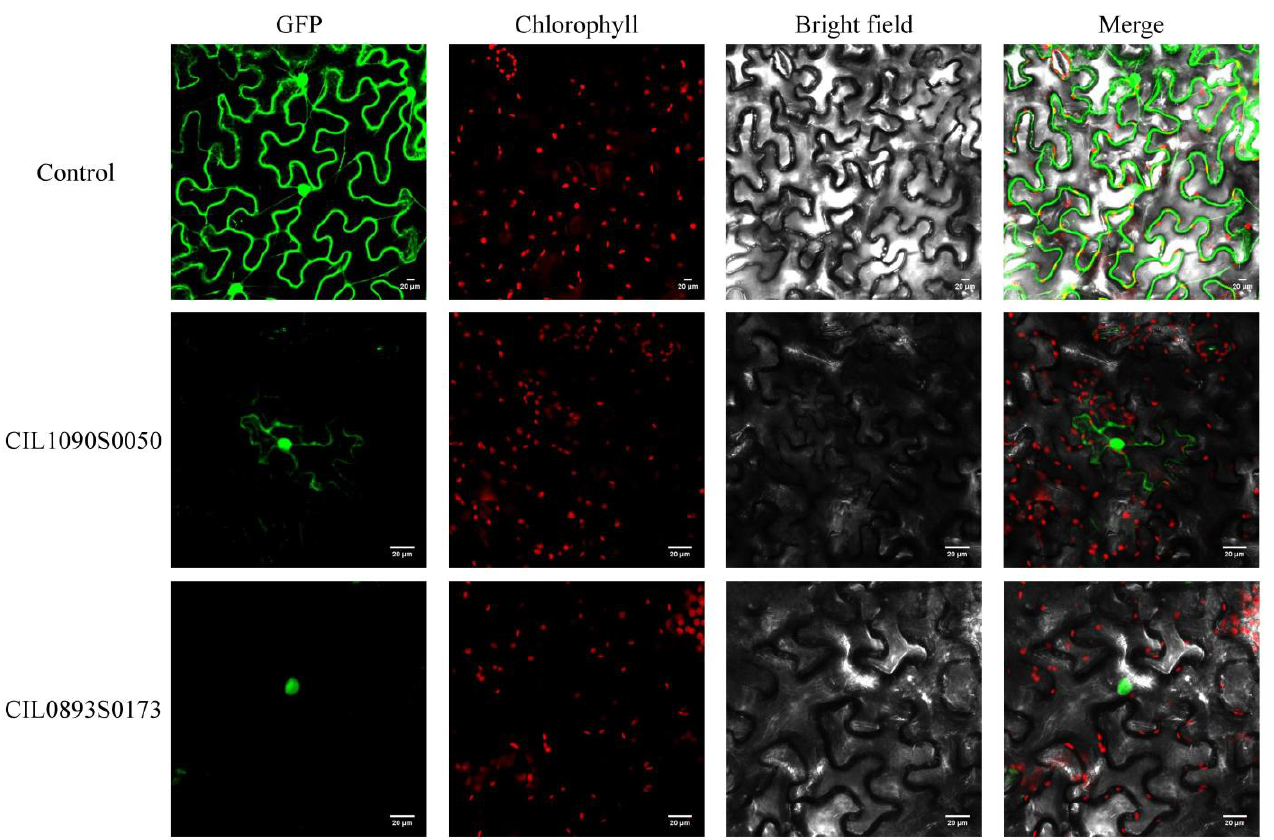
Figure 5. Subcellular localization of two selected genes by the transient expression of a fused fluorescent protein. Control, GFP alone. Bar = 20 µm.